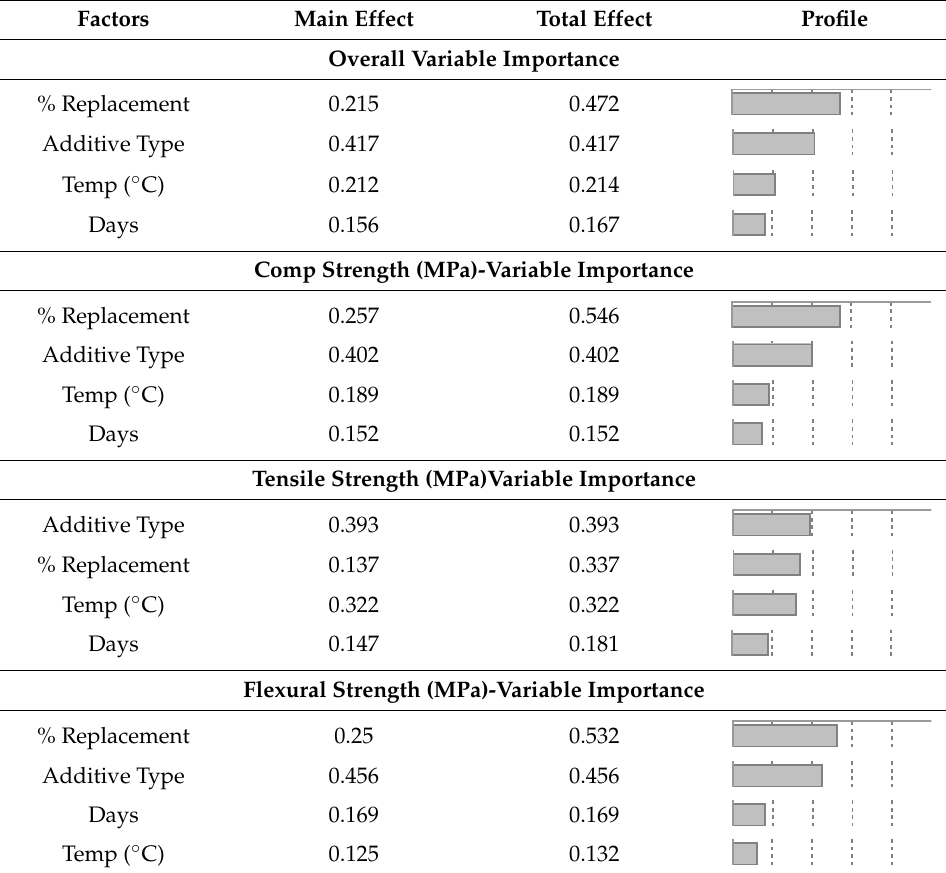
Table 9. Variable importance and impact of all strength parameters.